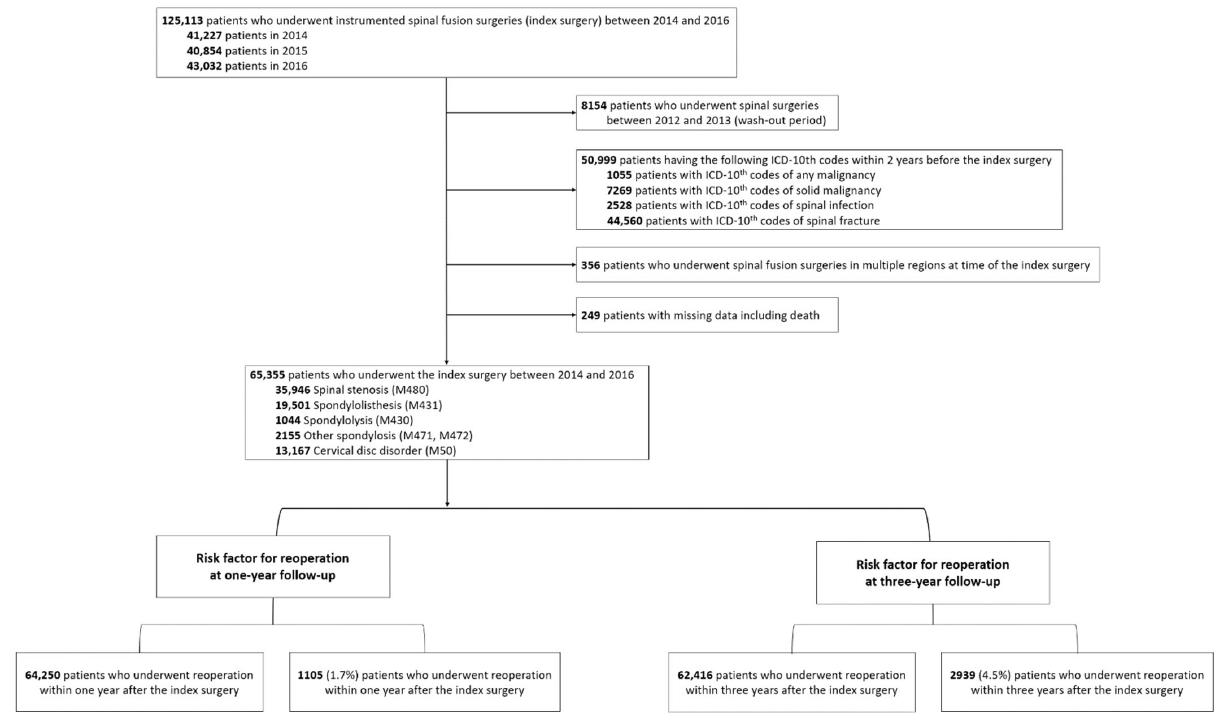
Figure 1. Selection of the study population.